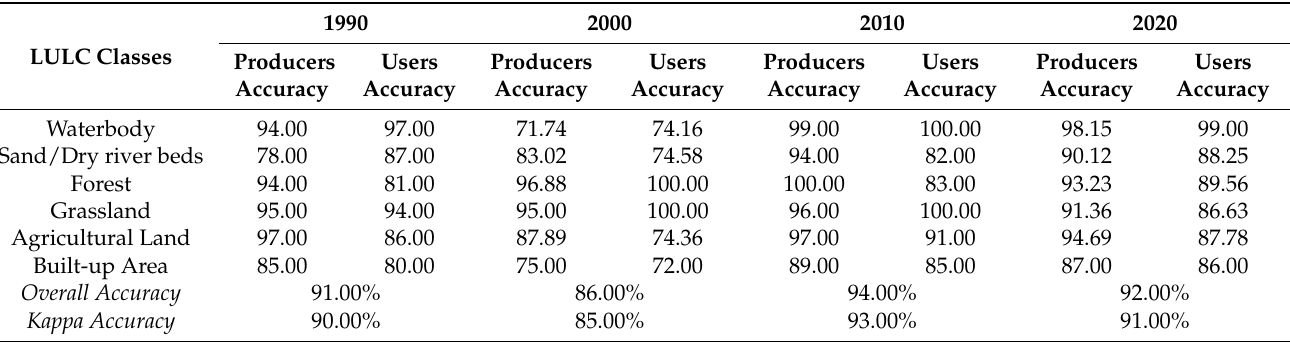
Table 5. Accuracy assessment of the classified LULC